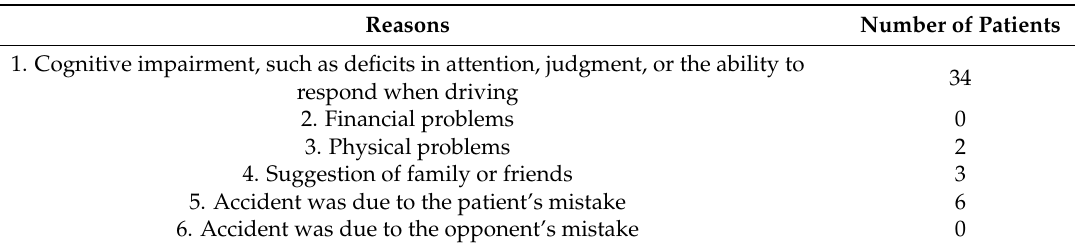
Table 1. Reasons for driving